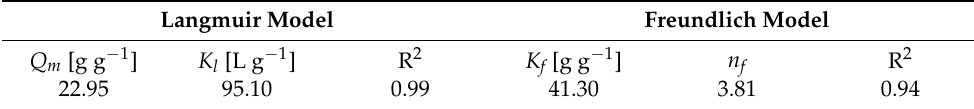
Table 4. Parameters estimated using the Langmuir and Freundlich